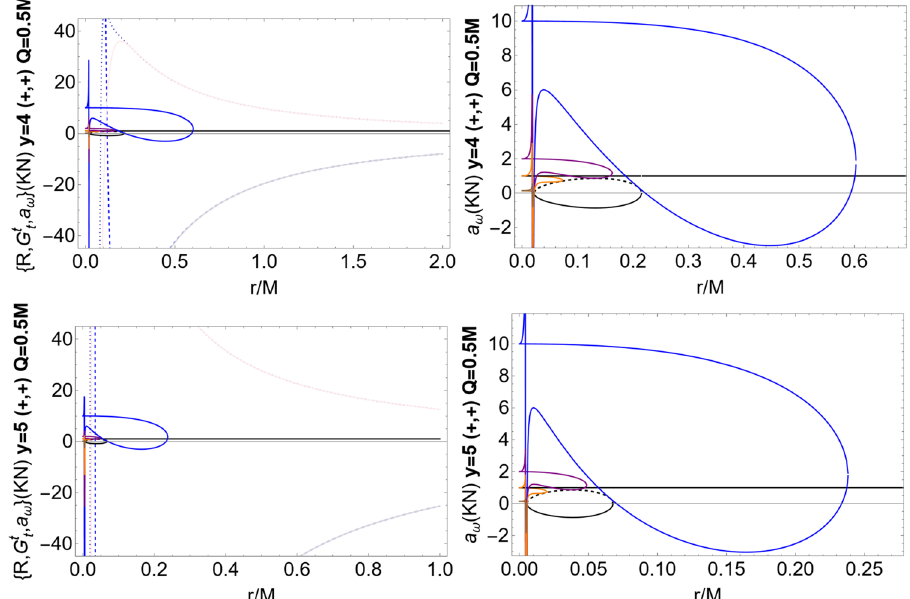
Fig. 25 Deformation of the Kerr–Newman reference metric in Boyer– Lindquistcoordinates(metricsignature ( − , + , + , + ) )ontheequatorial plane for charge Q = 0 . 5 and M = 1. Metric bundle a ω in the extended plane a − r , Ricci curvature scalar R and Einstein tensor component G t t are plotted for different deformation parameters { ( b , f ), y } , where { blue , purple , orange , bro w n } curves refer to frequencies { ω =